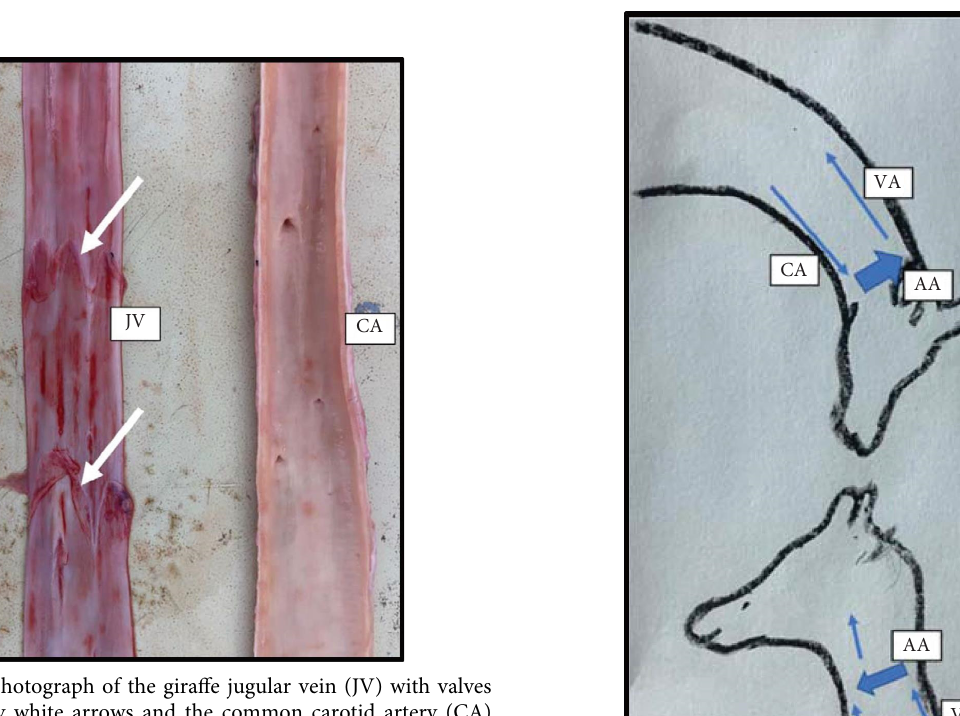
Figure 5: (a) Doppler waveform with color fow images demonstrated preferential fow in the anastomotic artery directed away from the common carotid artery towards the vertebral artery, in the head-down position. (b) Visual illustration of the latex model during detailed dissection of the carotid-vertebral anastomosis with the direction of fow (yellow arrow) away from the common carotid artery (CCA) towards the vertebral artery (VA), in the head-down position.